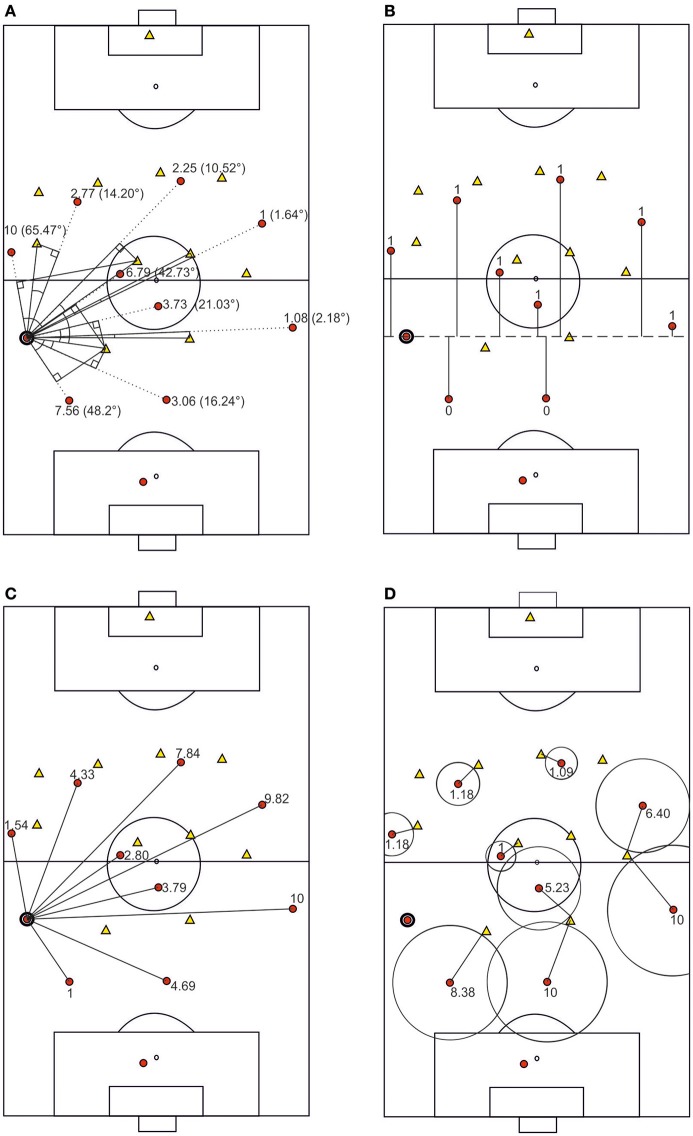
Visual illustration of the four variables: openness of passing lane (A) position relative to the ball (B) distance (C) and defensive coverage (D). The numbers represent normalized values, as used in the logistic regression models.